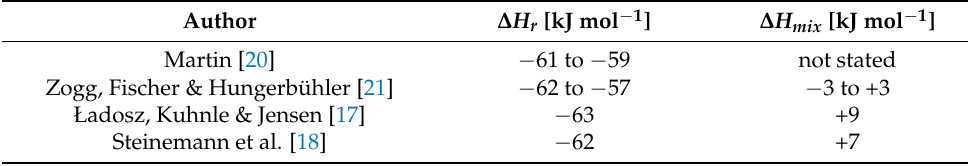
Table 2. Thermokinetic parameter of the hydrolysis of acetic anhydride.